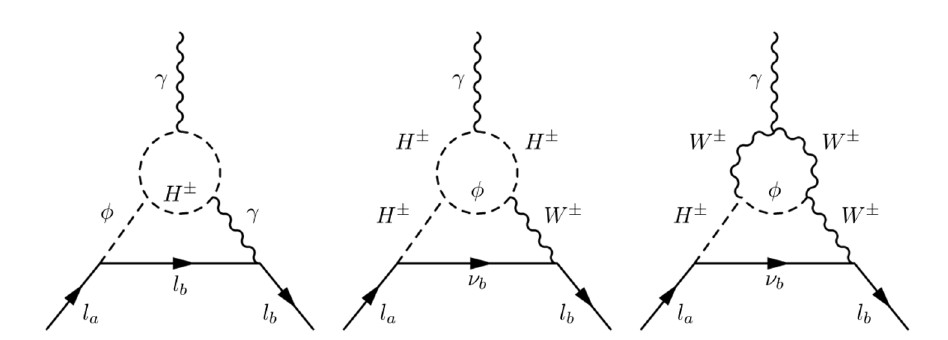
Figure 7 . Two-loop bosonic Barr-Zee diagrams contributing to muon g − 2 and l → l 0 γ . The indices a, b correspond to any of the lepton flavours e, µ, τ , and we have φ = h, H, A . In the left panel, the internal photon γ may be replaced by a Z boson, and the internal H ± with a W ±